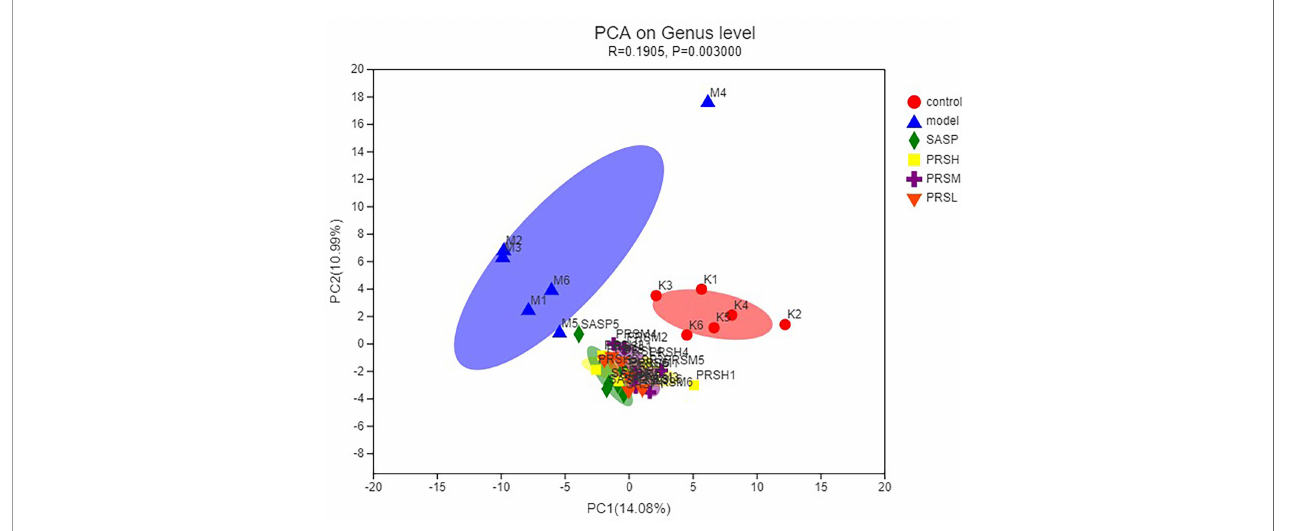
FIGURE 8 | PCoA analysis of intestinal microbes in UC